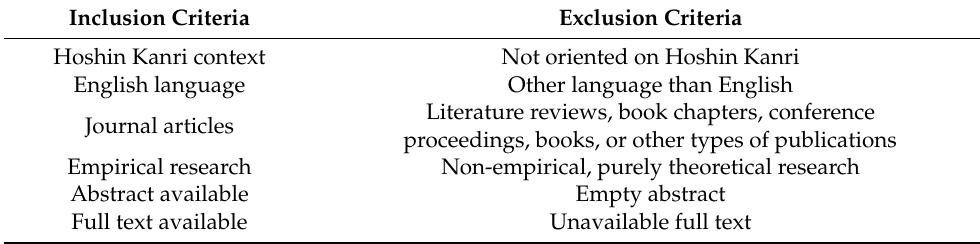
Table 2. Inclusion and exclusion criteria.